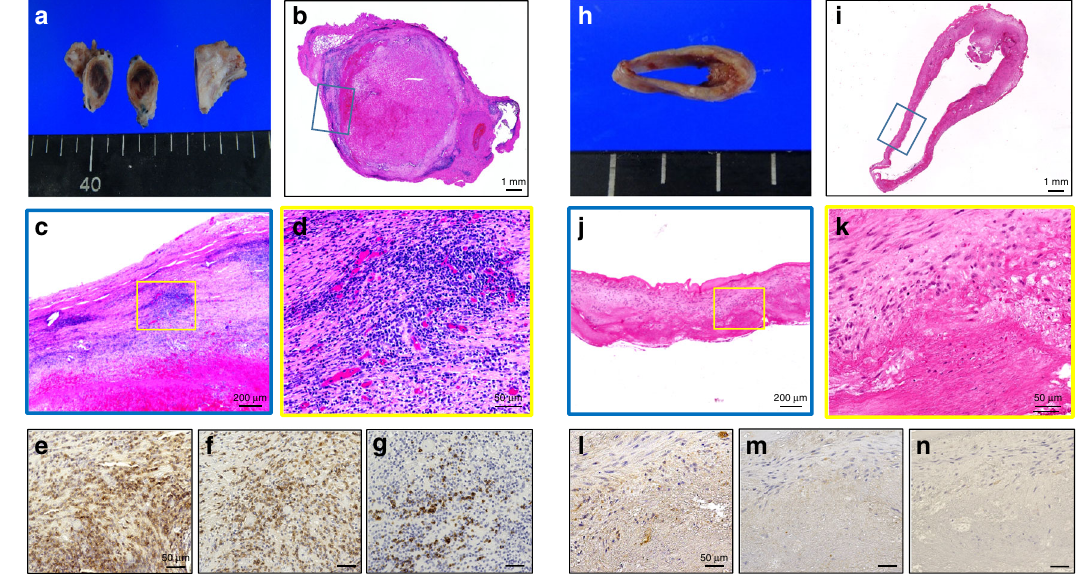
Fig. 3 A histological analysis of the patent or rejected HOBPTs at 2 weeks after transplantation. The lumen of the HOBPT in the CISP group was completely obstructed by thrombus a , b , but was patent in the OIDPs h , i . The lymphocyte in fi ltration in the HOBPT of the OIDP group j , k was drastically inhibited in comparison with the CISP group c , d . Immunohistochemically, the numbers of CD45 + common lymphocytes e , l , CD20 + B lymphocytes f , m and CD3 + T lymphocytes g , n in the OIDP group l – n were signi fi cantly decreased in comparison with the CISP group e – g . Scale bar: 1 mm in b , i , 200 µ m in c , j , 50 µ